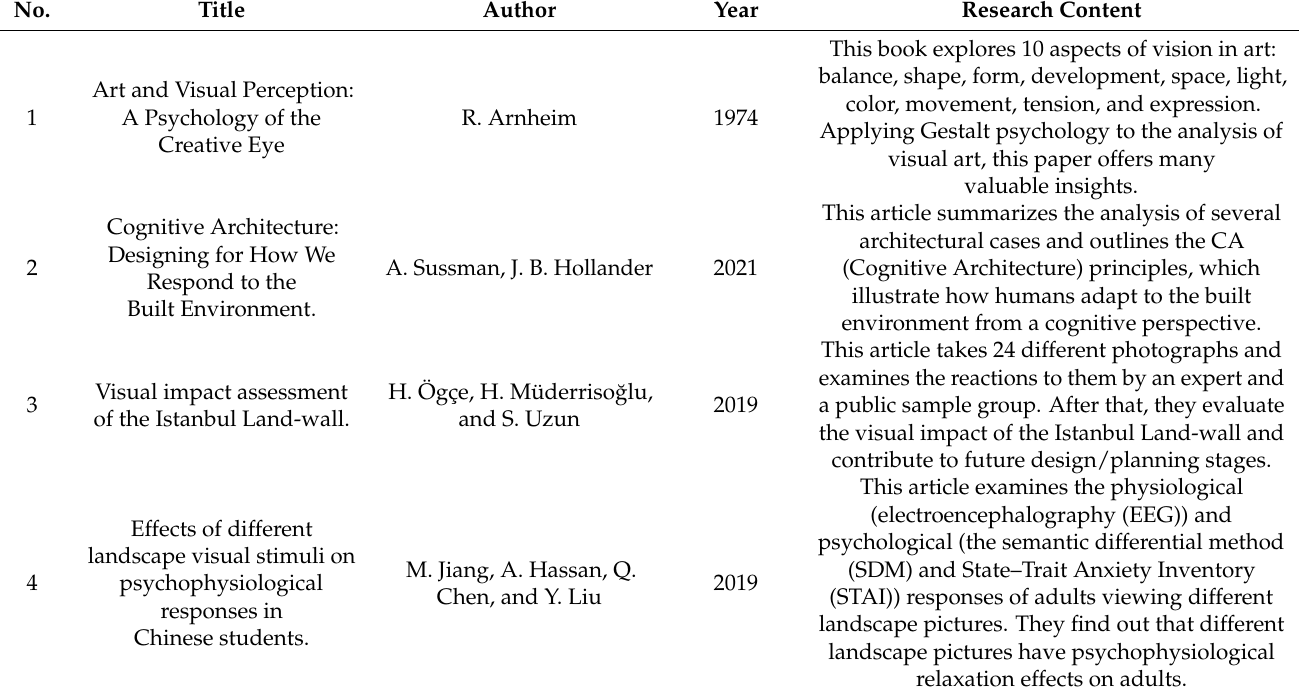
Table 1. Literature review of the relationship between visual perception and architectural